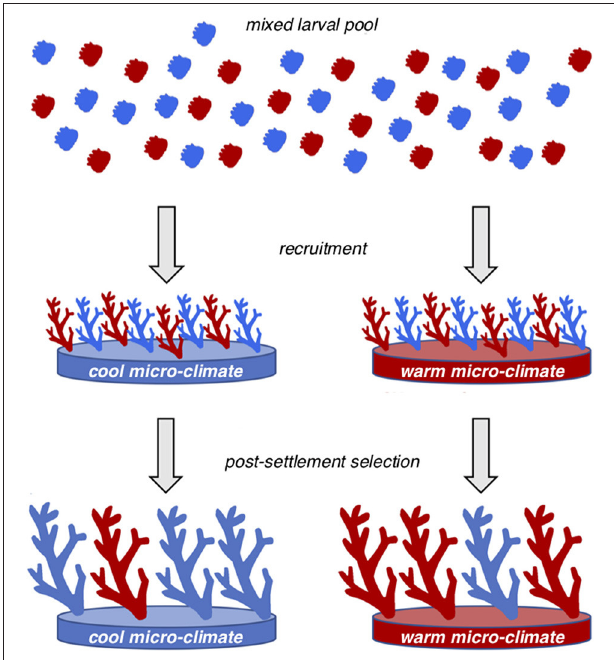
FIGURE 4 | The Levene (1953) model of spatially varying selection to explain patterns of local adaption between pools amidst high gene